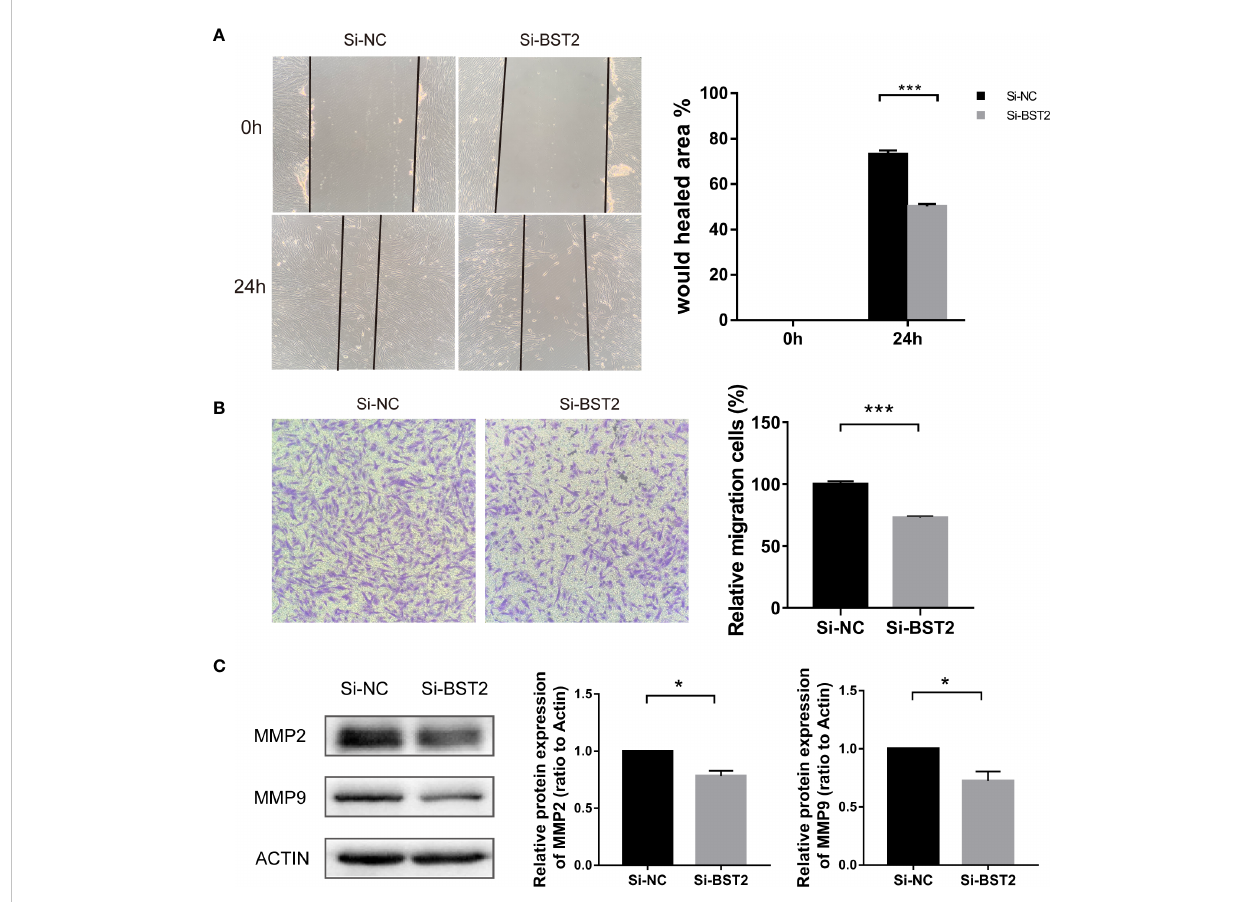
FIGURE 4 Effect of BST2 on cell migration. (A) , Representative images and quanti fi cation of cell motility changes in wound healing assays at 0h and 24h. (B) , Representative images and quanti fi cation of transwell migration assays at 24h after BST2 knockdown. (C) , The migration-related protein bands were performed by the western blot assay after transfection with Si-BST2 or Si-NC for 48h. *p < 0.05; ***p <